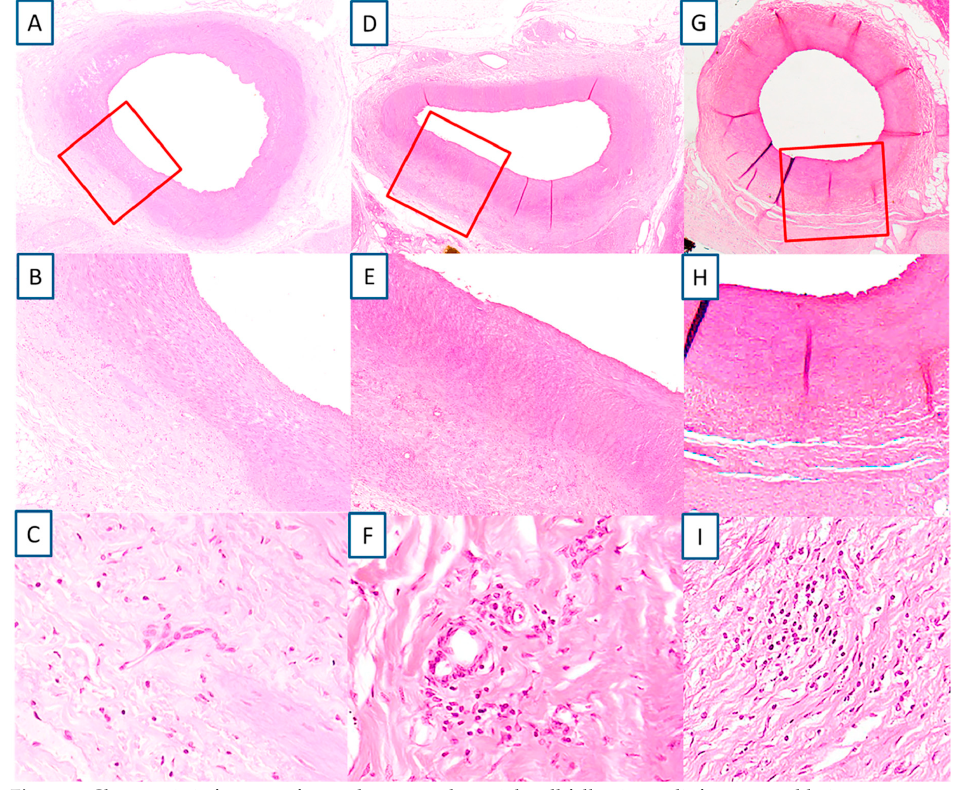
Figure 4. Characteristic features of a renal artery and arterial wall following radiofrequency ablation.